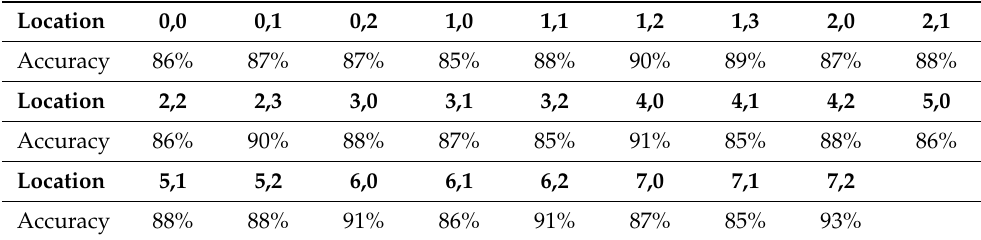
Table 10. Estimation accuracy of TAG location in real deployment.